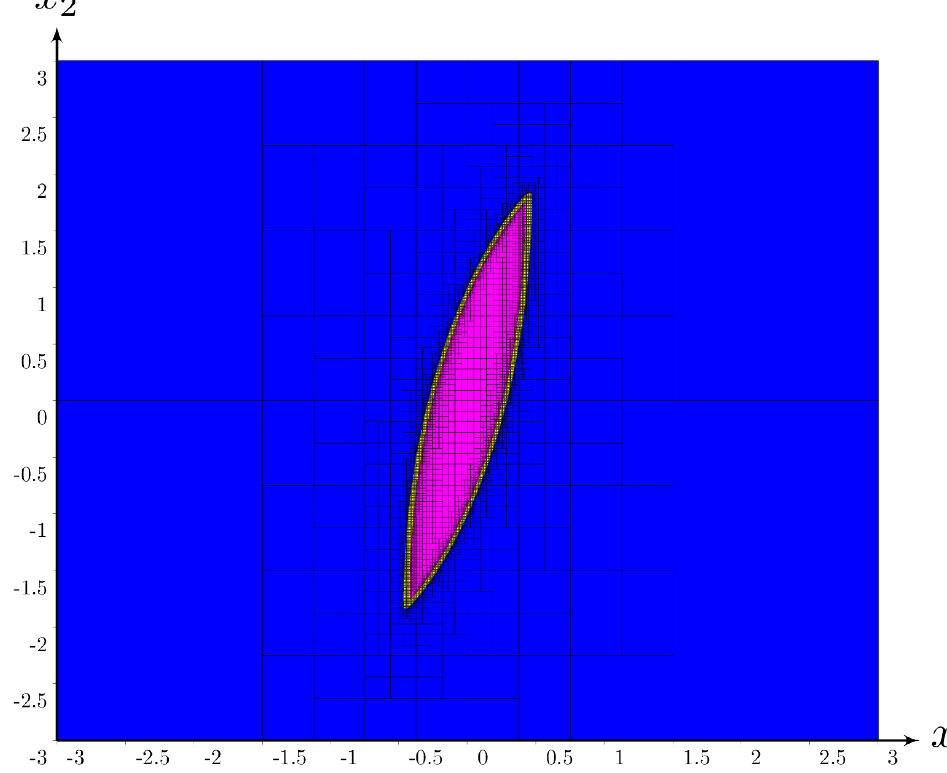
Figure 12. Approximation of the smallest positive invariant set containing 0